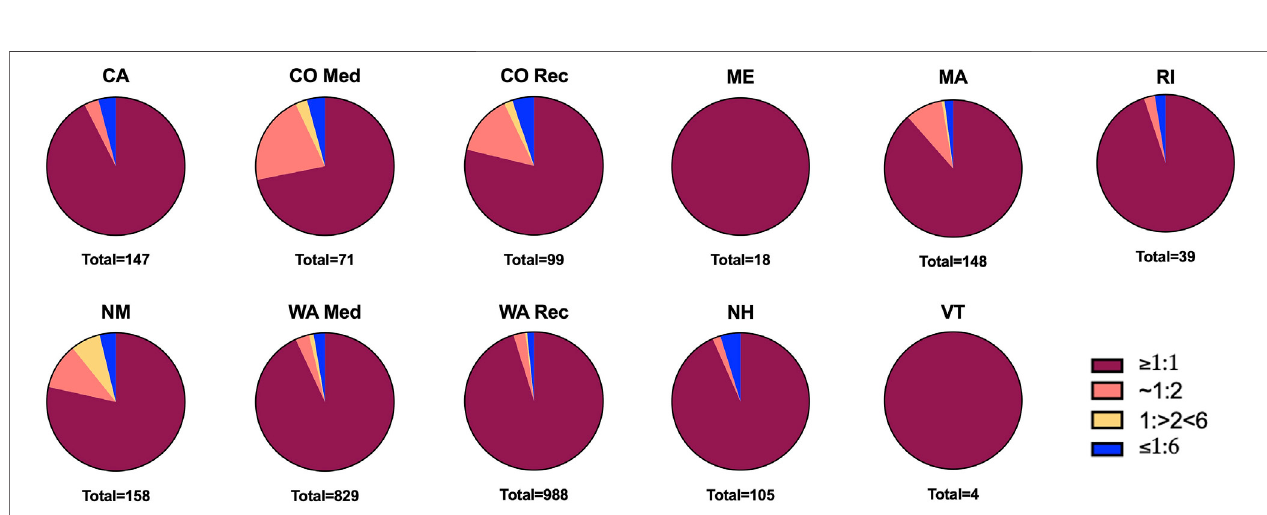
FIGURE 2 | Proportion of products within THC:CBD ratio categories per state. Total products per state listed below each graph.